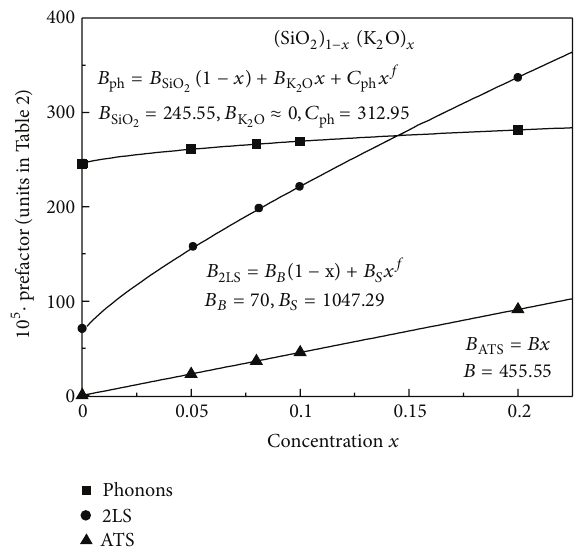
Figure 13: The 2LS and ATS prefactor parameters (×10 8 ) for all glasses (from Table 2) as a function of 𝑥 . The experimental data fit well with our theoretical expectations with 𝑓 = 0.81 (full